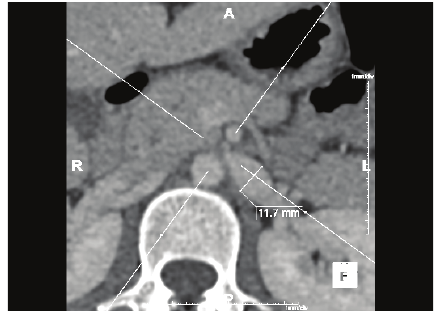
Figure 2: Axial contrast CT in our patient showing a grossly dilated LRV (11.7mm) prior to impingement due to mesoaortic compression.